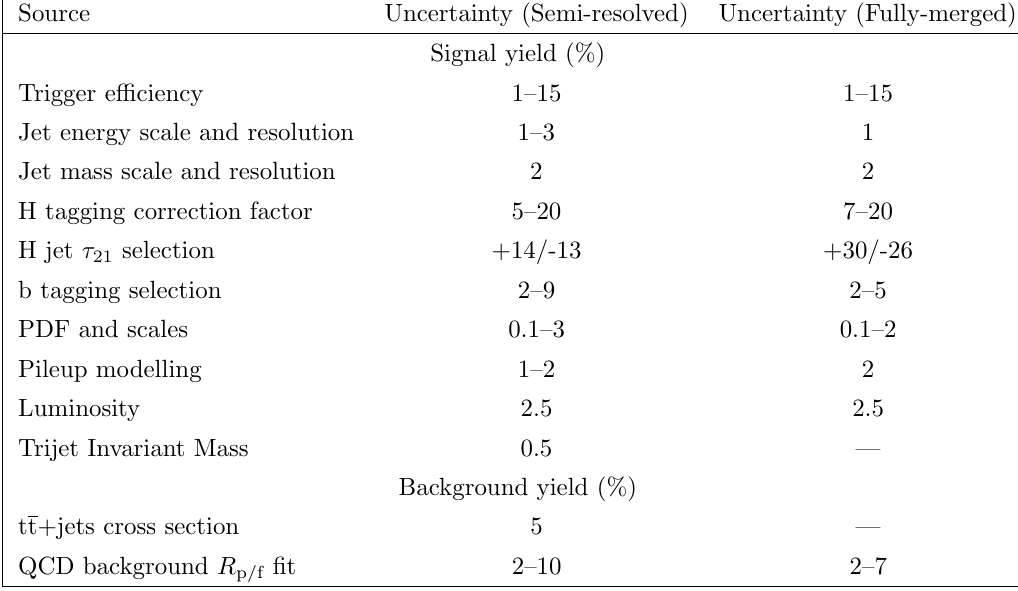
Table 3 . Summary of the ranges of systematic uncertainties in the signal and background yields, for both the semi-resolved analysis and for the fully-merged analysis, taken from ref. [39].